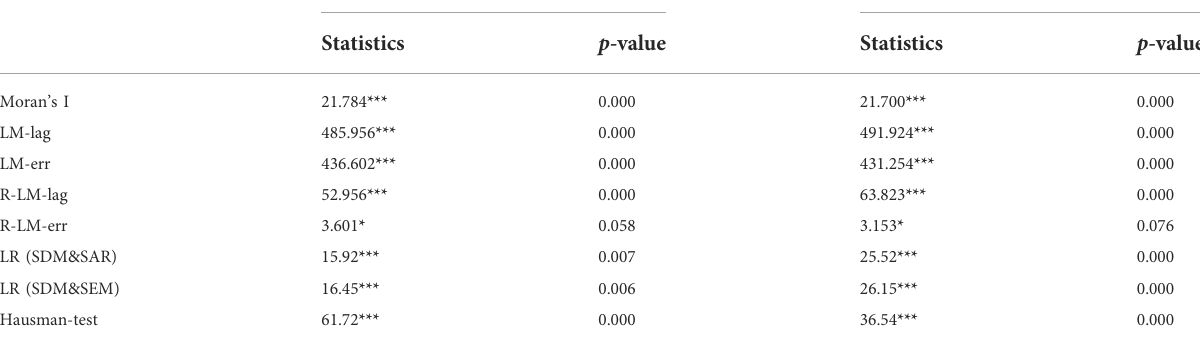
TABLE 1 Spatial econometric model testing.